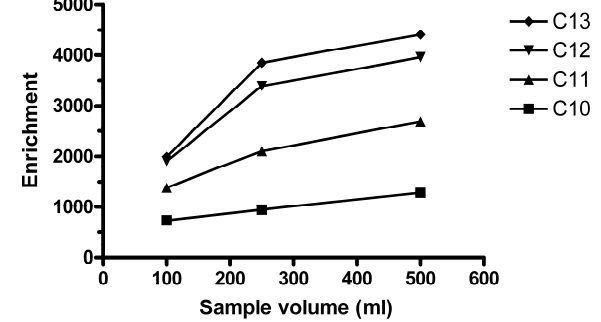
Figure 2. Effect of sample volume. Conditions as in Figure 1, except 32.5 mM acceptor buffer concentration. n = 2 for 100 and 500. n = 3 for 250